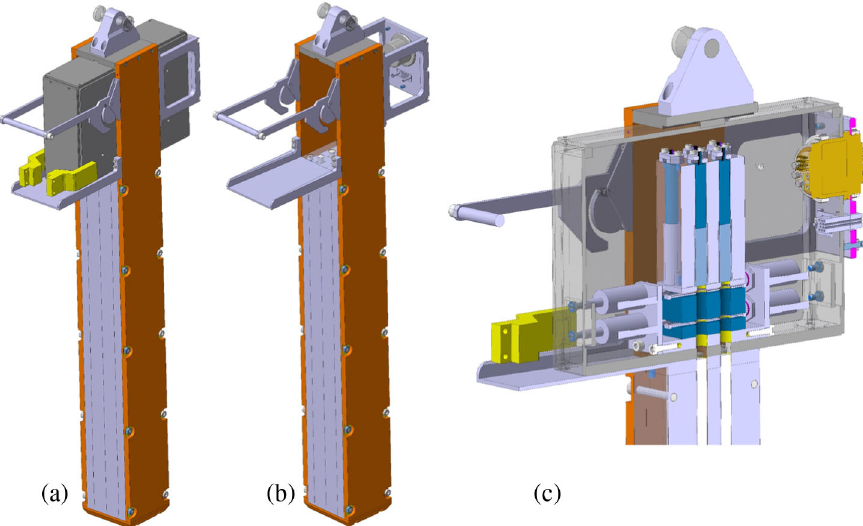
FIG. 15. BRAN-Q prototype assembly (a), featuring the copper enclosure for fused silica rods and the detection box. Assembly with the detection box removed (b), exposing the tip of fused silica rods. Section of the detection box